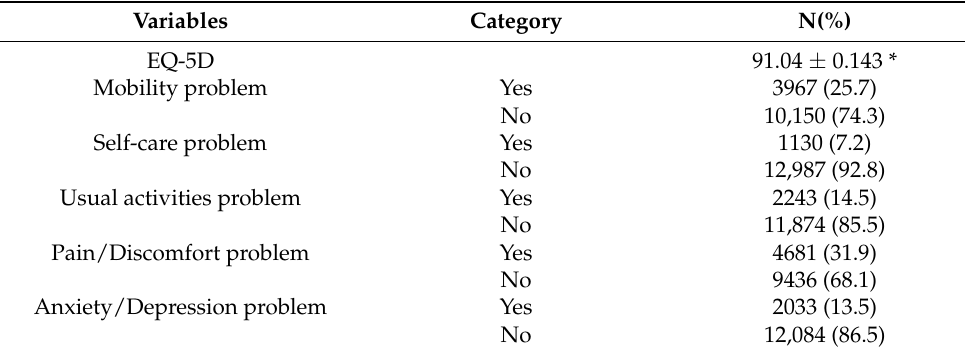
Table 2. Health-related quality of life.